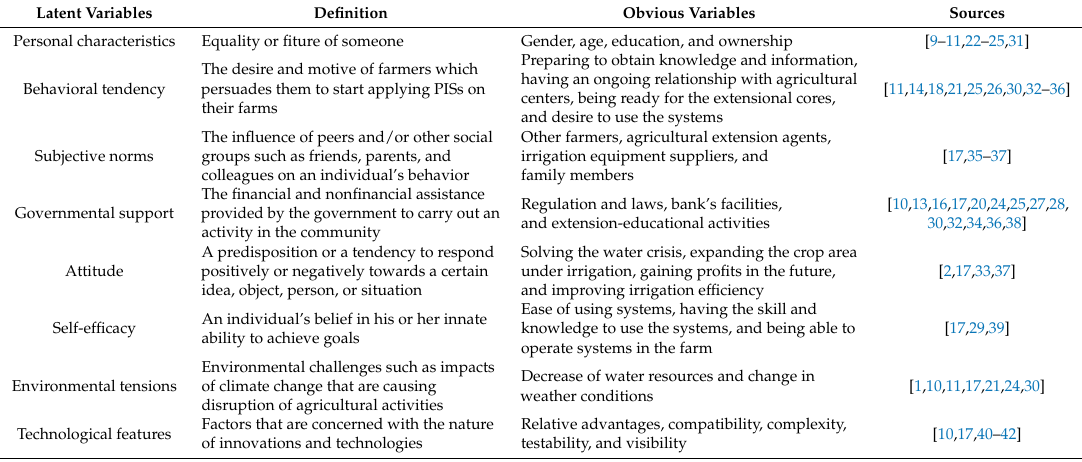
Table 2. Most important factors affecting the use of PISs by farmers (latent and obvious